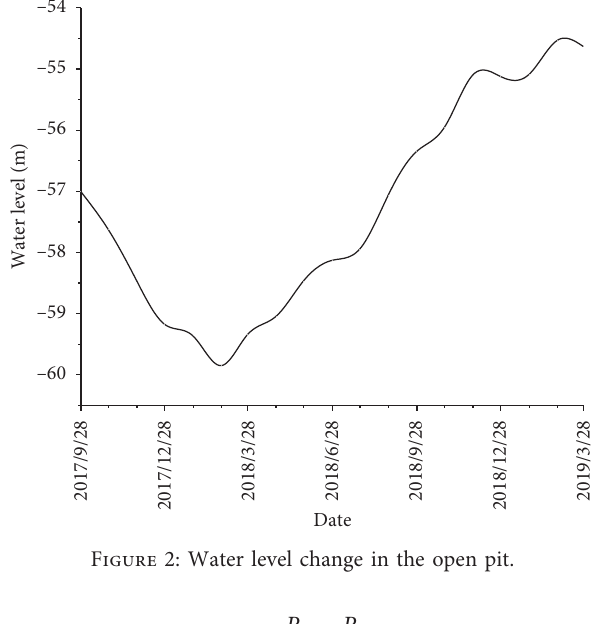
Figure 2: Water level change in the open